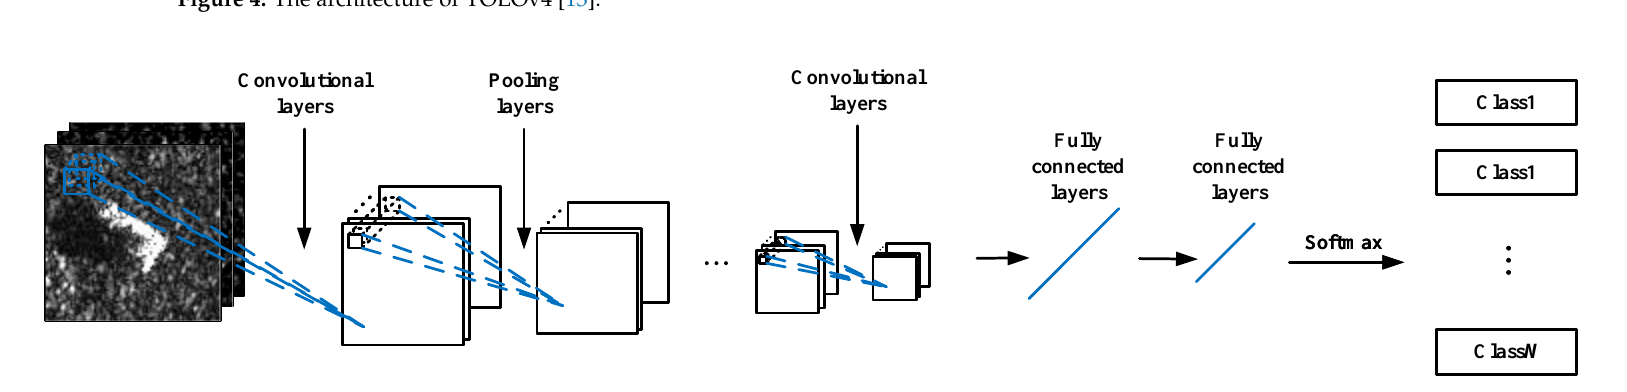
Figure 5. Architecture of amplitude–real–imaginary